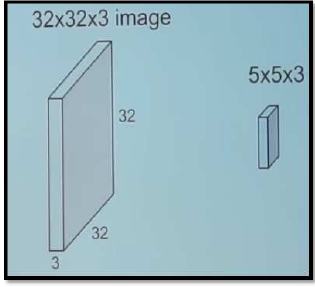
Figure 3. Convolution